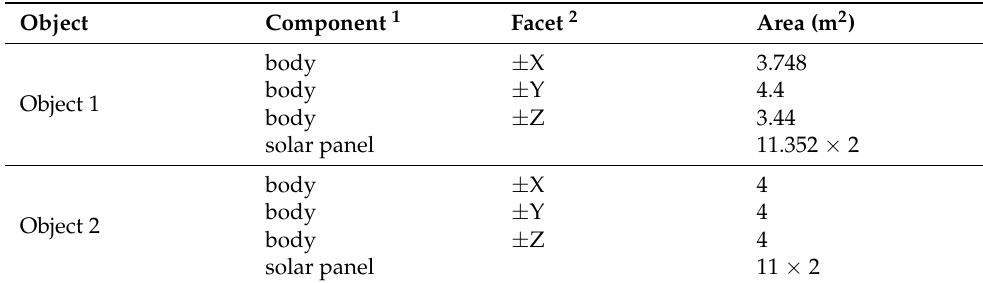
Table 2. The shape parameters of simulation